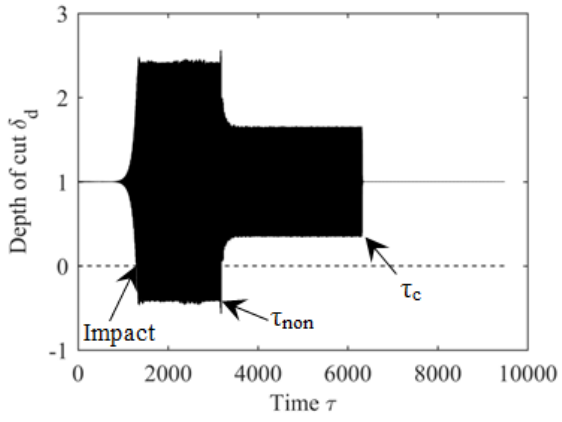
Fig. 12. Time histories with both the nonlinear velocity feedback and the chaos